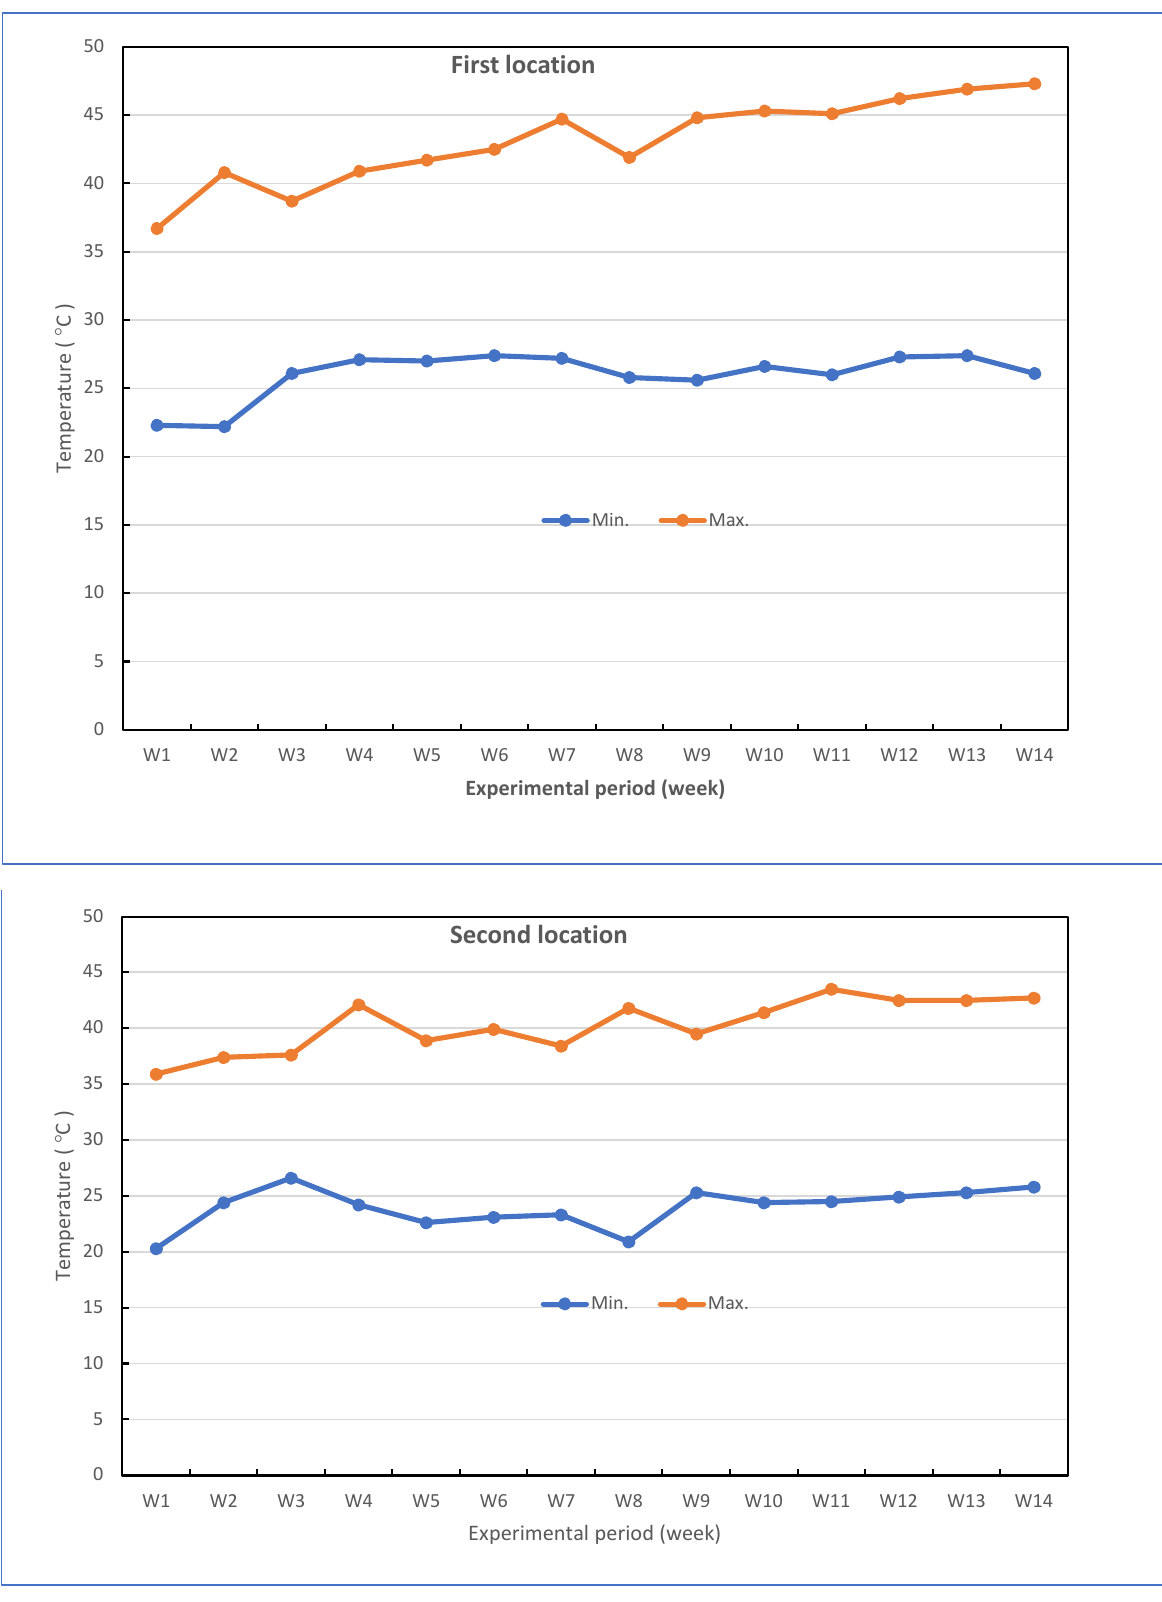
Figure 7. Weekly air temperature inside the net-house conditions during the experiment period in both locations.